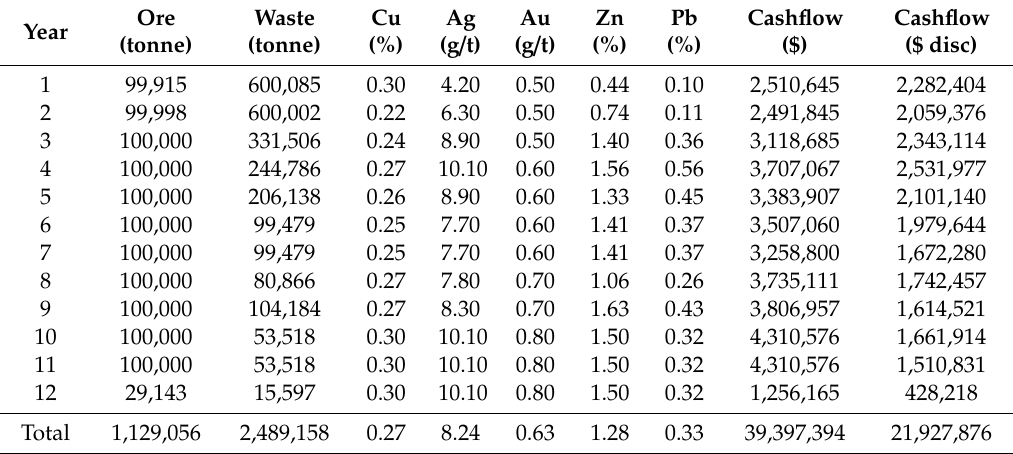
Table 3. Results of economic analysis performed in software